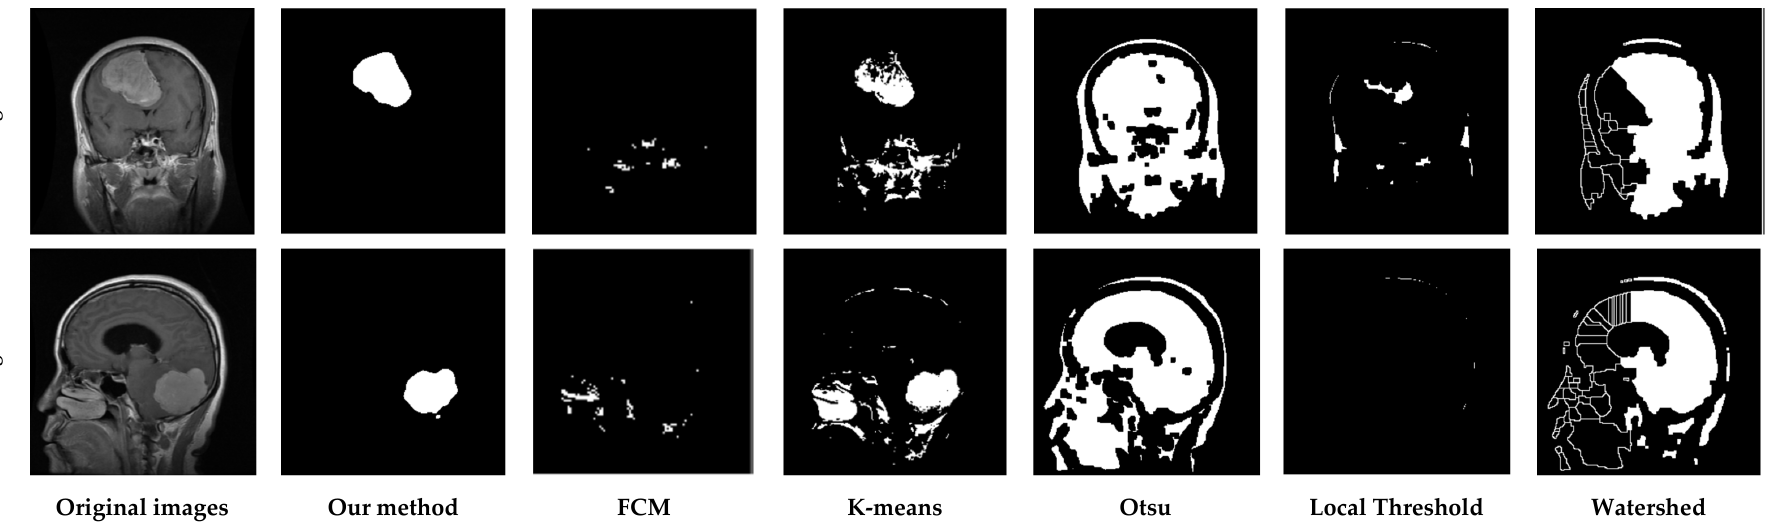
Figure 14. The efficiency of brain tumor segmentation on the KICA dataset: comparison between the proposed ANOVA-based method and other well-known